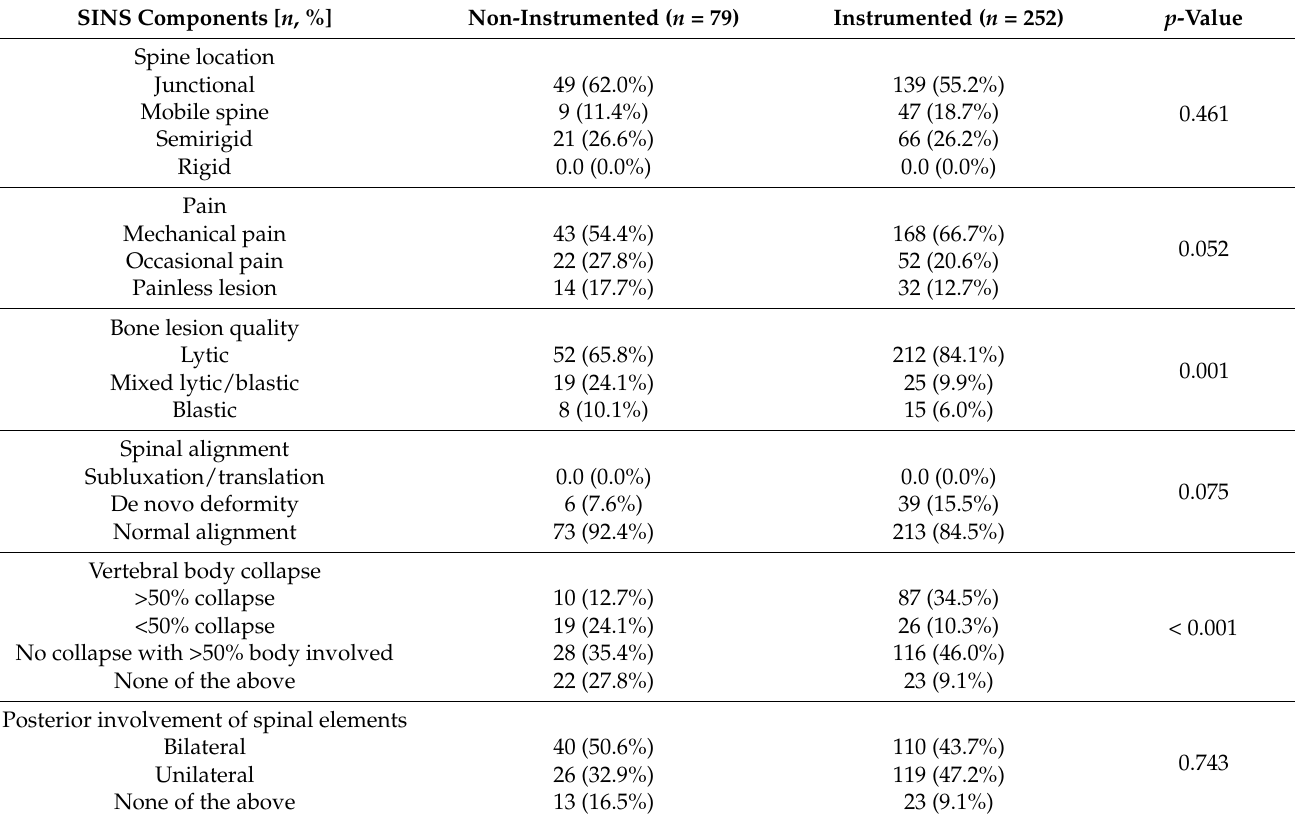
Table 2. Spinal instability neoplastic score